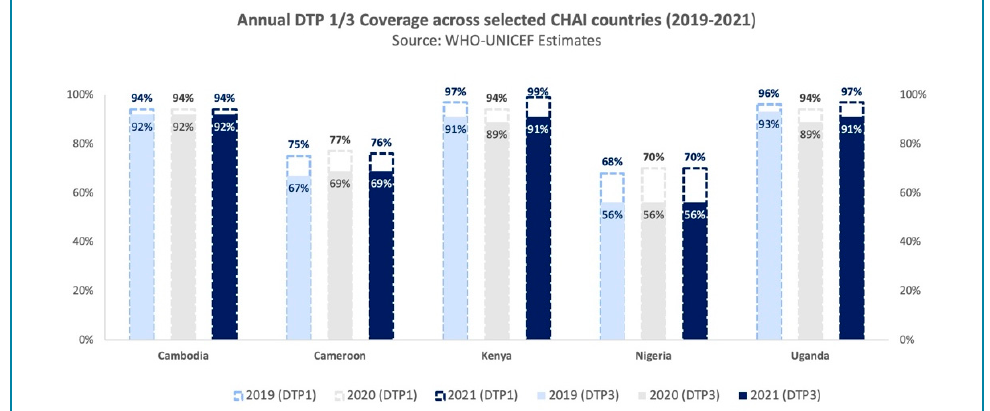
Figure 1. Graph representing DTP1/3 coverage levels in selected program countries—Cambodia, Cameroon, Kenya, Nigeria, and Uganda—between 2019 and 2021. It highlights that across these five countries, national coverage of DTP3 remained the same or increased between 2019 and 2021, showcasing the immunization systems’ resilience to withstand shocks due to the COVID-19 pandemic. Source: 2021 WHO-UNICEF Estimates.